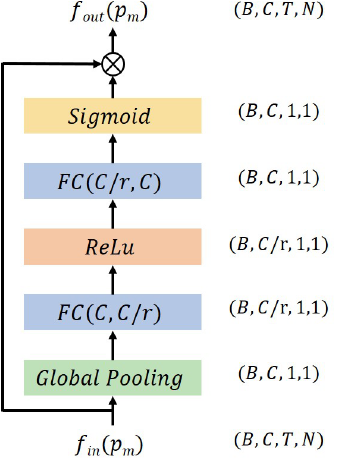
Figure 4. Architecture of the proposed part attention module.